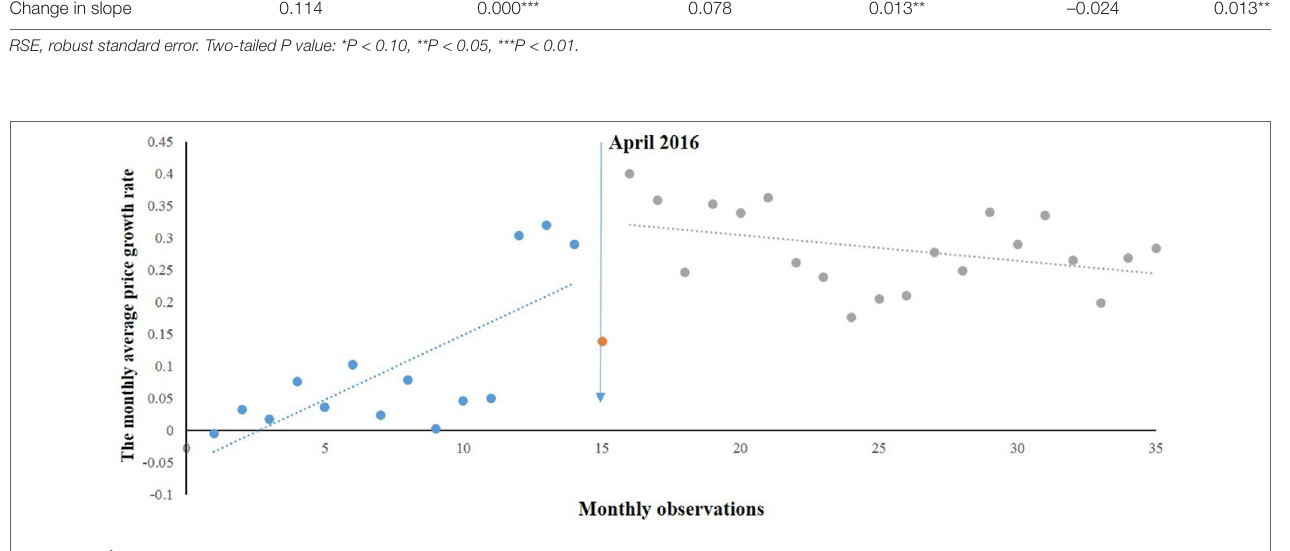
FIGURE 4 | Segmented regression model showing MPRp from 2015 to